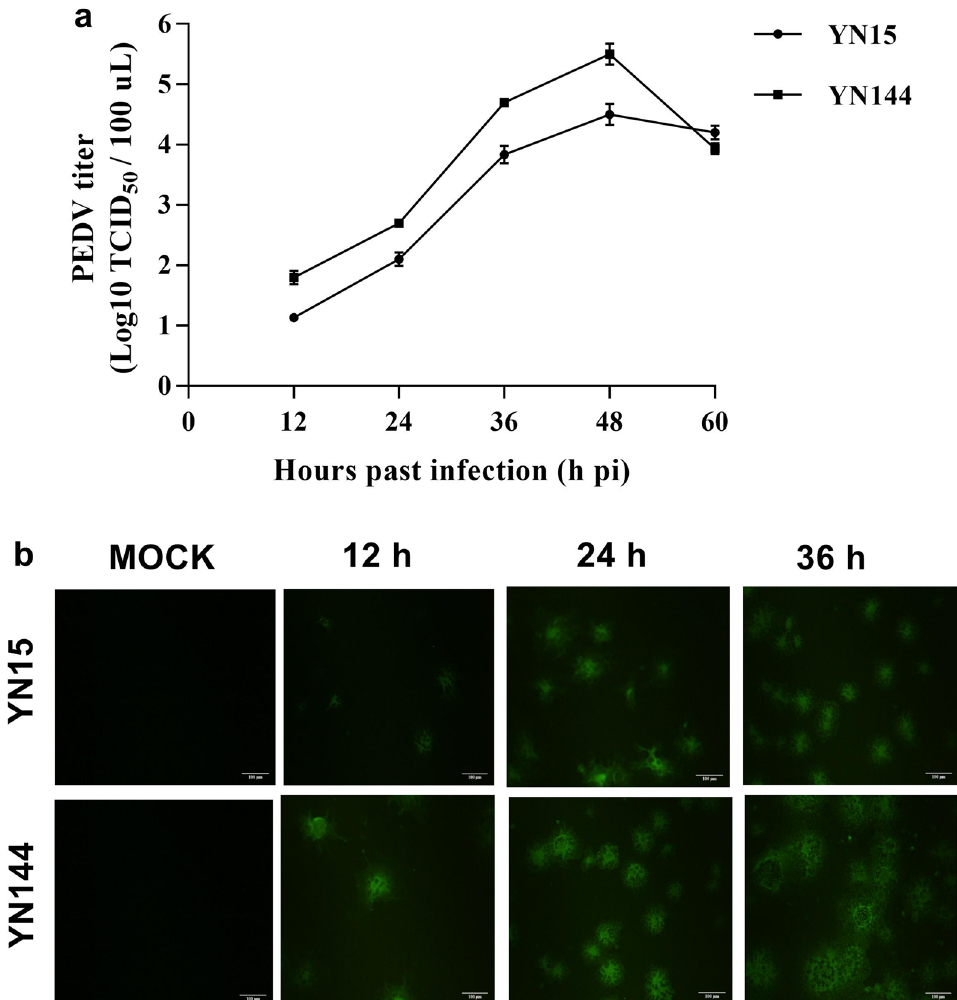
Figure 1. The growth curves of the two PEDV strains (YN15 and YN144) in ST cells (0.001 multiplicity of infection (MOI)). ( a ) The growth curves of the two PEDV strains (YN15 and YN144) in ST cells. ( b ) Confirmation of YN15 and YN144 replication in ST cells at 12, 24, and 36 h pi by IIFA. Mock-infected ST cells at 36 h pi were set as control. Scale bar = 100